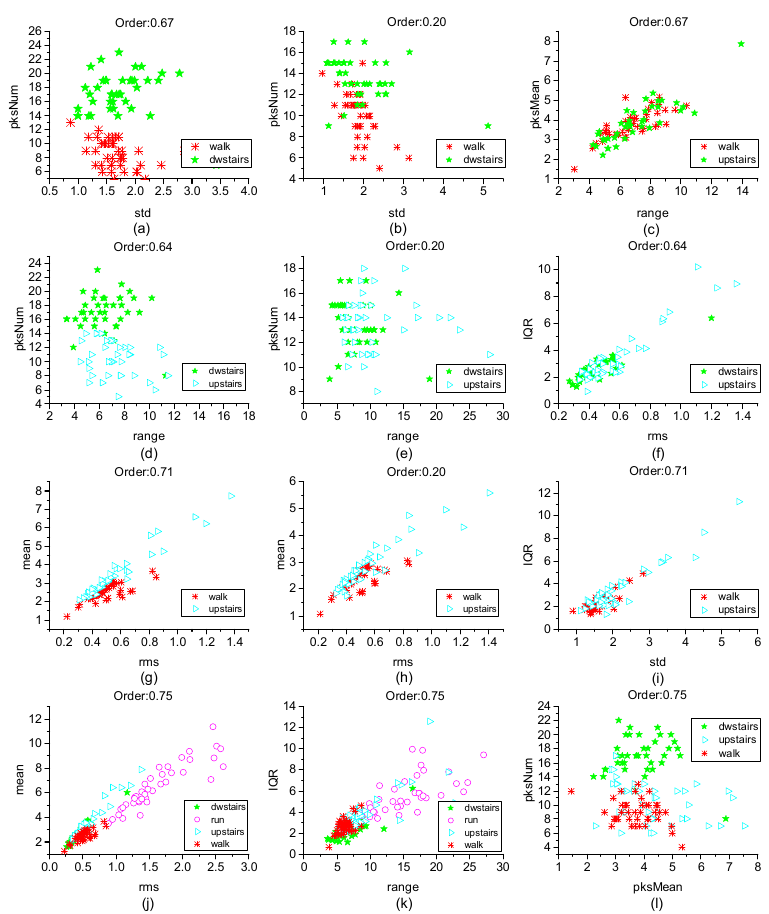
Figure 12. The e ff ect of classification. ( a ) walk and dwstairs with the features std and pksNum when Order = 0.67; ( b ) walk and dwstairs with the features std and pksNum when Order = 0.20; ( c ) walk and dwstairs with the features range and pksMean when Order = 0.67; ( d ) dwstairs and upstairs with the features range and pksNum when Order = 0.64; ( e ) dwstairs and upstairs with the features range and pksNum when Order = 0.20; ( f ) dwstairs and upstairs with the features rms and IQR when Order = 0.64; ( g ) walk and upstairs with the features rms and mean when Order = 0.71; ( h ) walk and upstairs with the features rms and mean when Order = 0.20; ( i ) walk and upstairs with the features std and IQR when Order = 0.71; ( j ) all the actions with the features rms and mean when Order = 0.75; ( k ) all the actions with the features range and IQR when Order = 0.75; ( l ) all the actions with the features pksMean and pksNum when Order = 0.75.